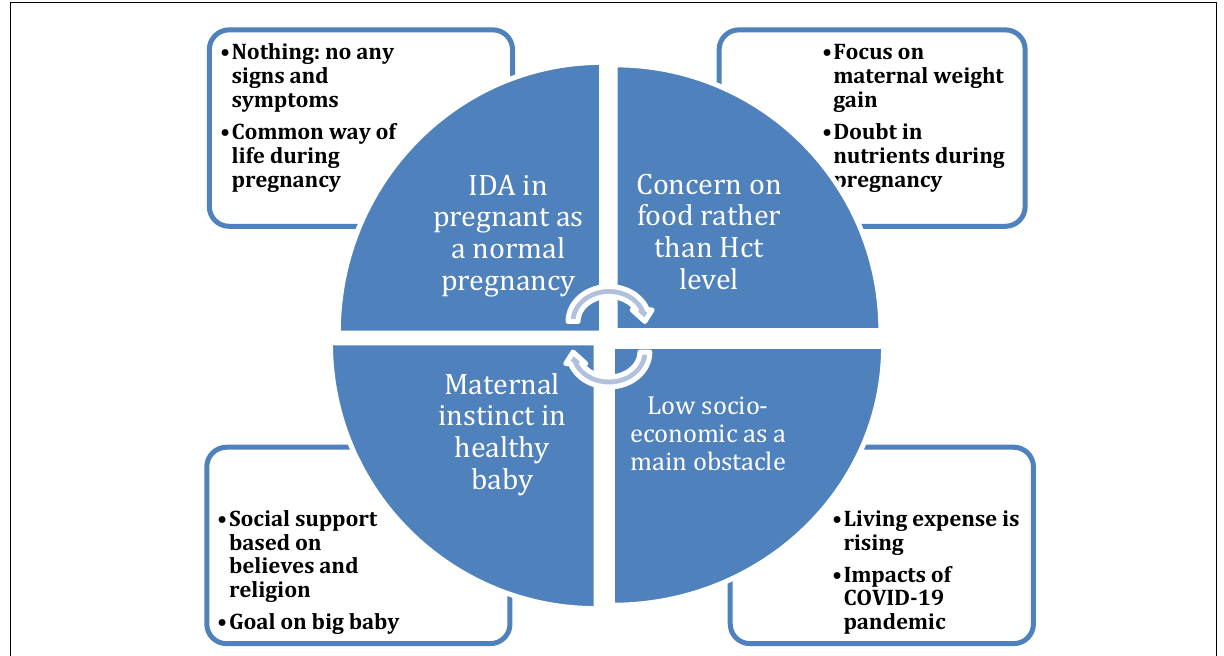
Figure 1. Themes and sub-themes of pregnant women with